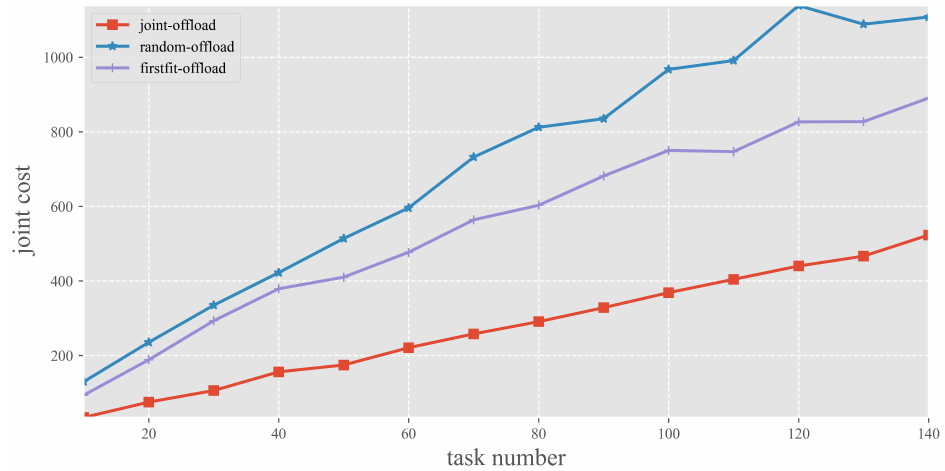
Figure 15. Joint optimization cost of the three offloading strategies varies with the number of tasks in the whole constellation offloading